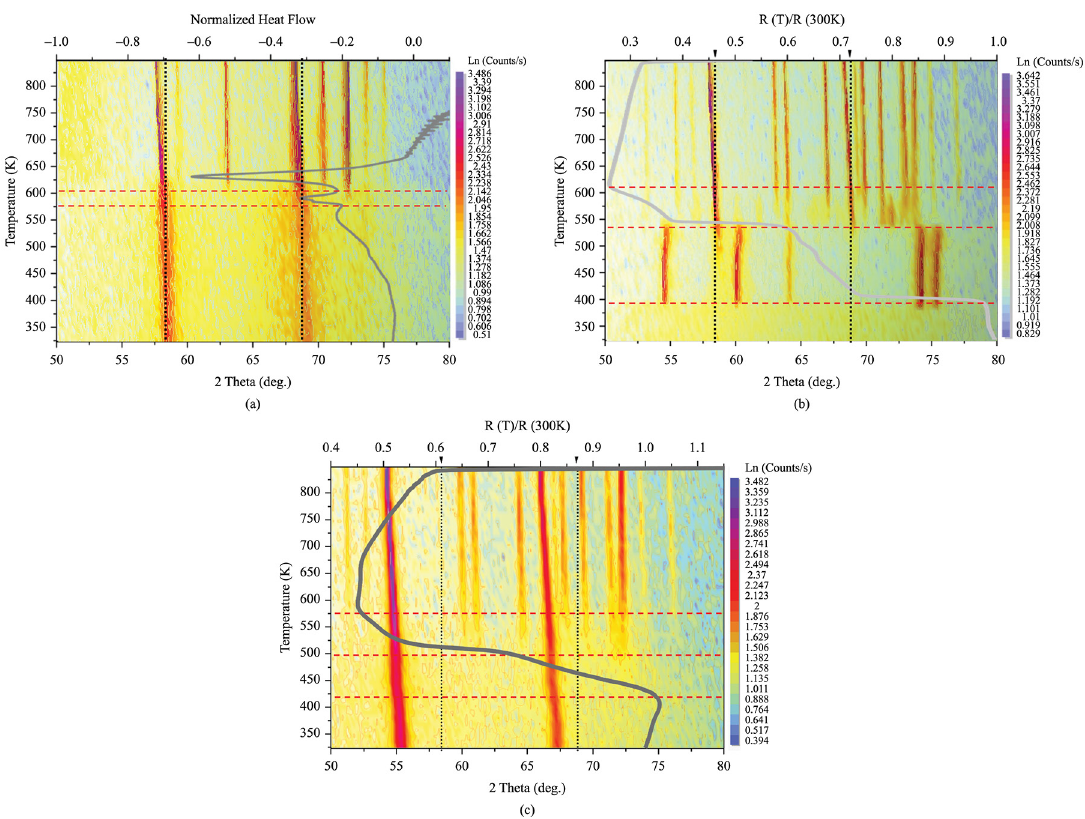
Ni Si alloy in as-cast state (a), and during in-situ heat treatment at 500K (b), 600K (c) and 800K (d). 75 10 20